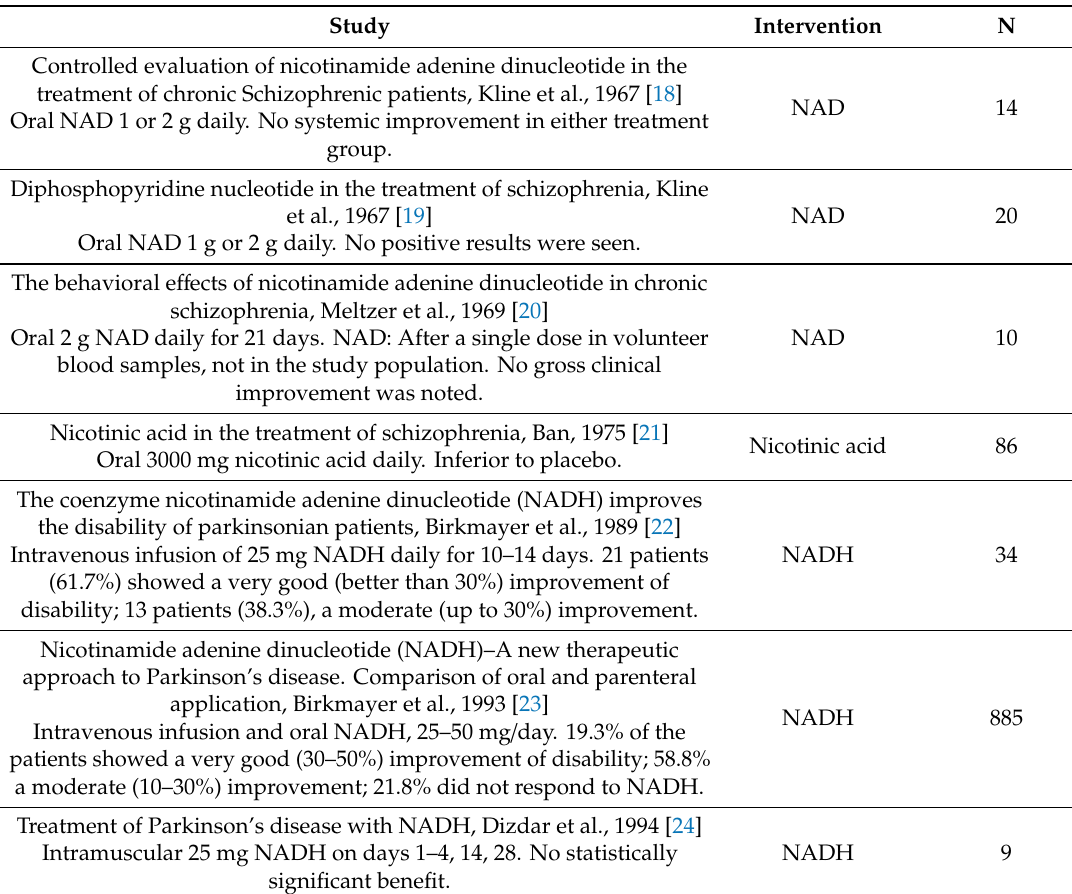
Table 1. Studies of NAD pharmacology and related